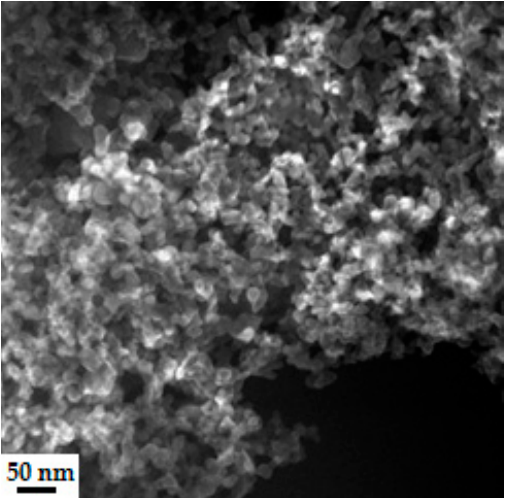
Figure 2. Morphology of Al 2 O 3 nanoparticles in Imeris W440 polymer binder.